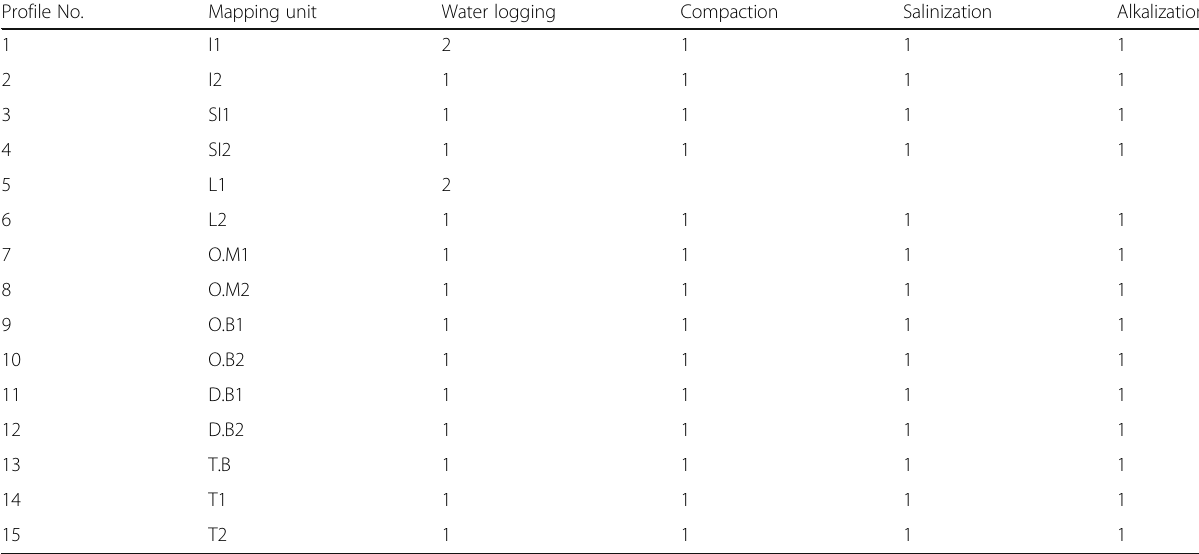
Table 10 Land degradation rates in the different mapping units of the study area Profile